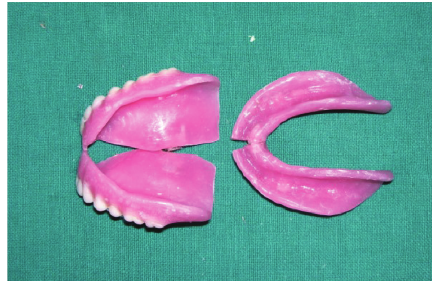
Figure 5: Foldable complete denture.